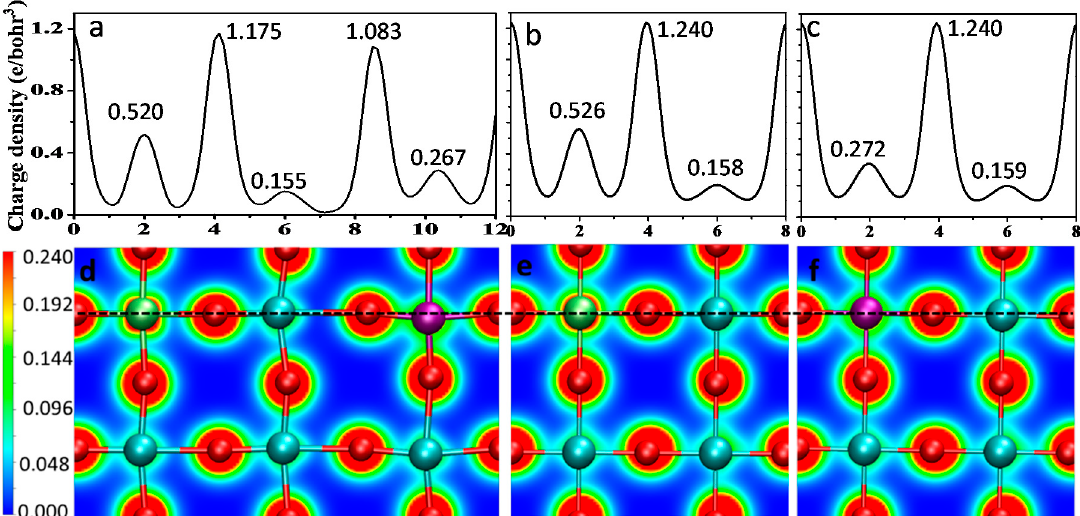
Figure 11. Charge-density distributions of metal doped BaTiO 3 in (100) surfaces: ( a – c ) Line profiles corresponding to the black dotted lines; ( d ) V and Cr co-doped BaTiO 3 ; ( e ) Cr doped BaTiO 3 ; ( f ) V doped BaTiO 3 .